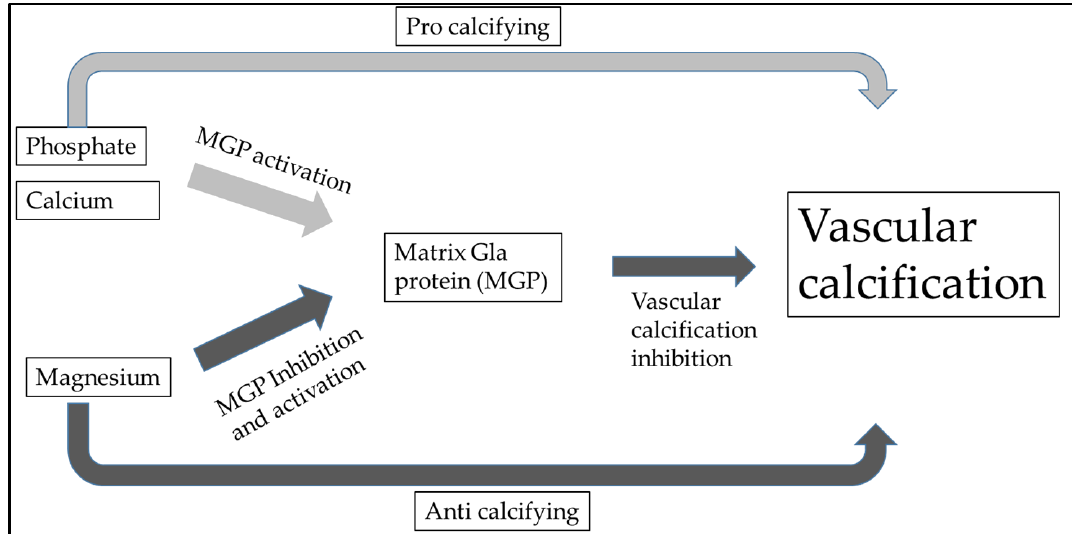
Figure 2. Vitamin K-dependent matrix Gla protein (MGP) is a crucial inhibitor of vascular calcification (VC) and is regulated with magnesium. This also shows that the appropriate magnesium level contributes to the prevention of vascular calcification.